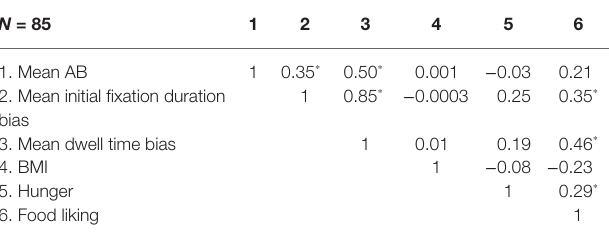
TABLE 4 | Correlations between BMI, hunger level, food liking, and mean attentional bias